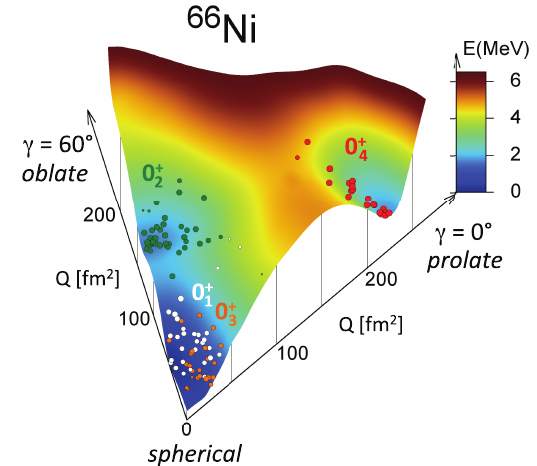
Figure 12. PES and T-plot for 66 Ni. Taken from Figure 1 of [64]. Each φ k has intrinsic quadrupole moments ( (cid:104) φ k | ˆ Q 0 | φ k (cid:105) and (cid:104) φ k | ˆ Q 2 | φ k (cid:105) ), where ˆ Q 0,2 imply the operators for Q 0,2 mentioned above. The T-plot circle for φ k is placed according to those values on the PES with its area proportional to the overlap probability with the corresponding eigenstate, i.e., Ψ in Equation (16). Such T-plot circles are shown in Figure 12. The white circles represent the MCSM basis vectors for the ground state, while the red circles indicate the MCSM basis vectors for the 0 + state, which is strongly deformed. 4 Although there is no local minimum for oblate shape, the 0 + state is shown to be moderately 2 oblate deformed. The T-plot can thus give partial labeling to fully correlated eigenstates for mean values as well as fluctuations with respect to their quadrupole shapes. The